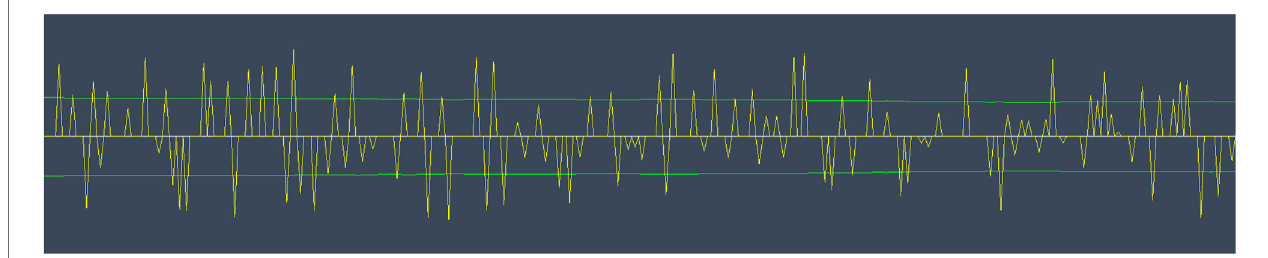
FIGURE 6 | Visualization of the processed pupil diameter signal (yellow) and the threshold used for calculating the Low/High Index of Pupillary Activity (green) (Duchowski et al.,